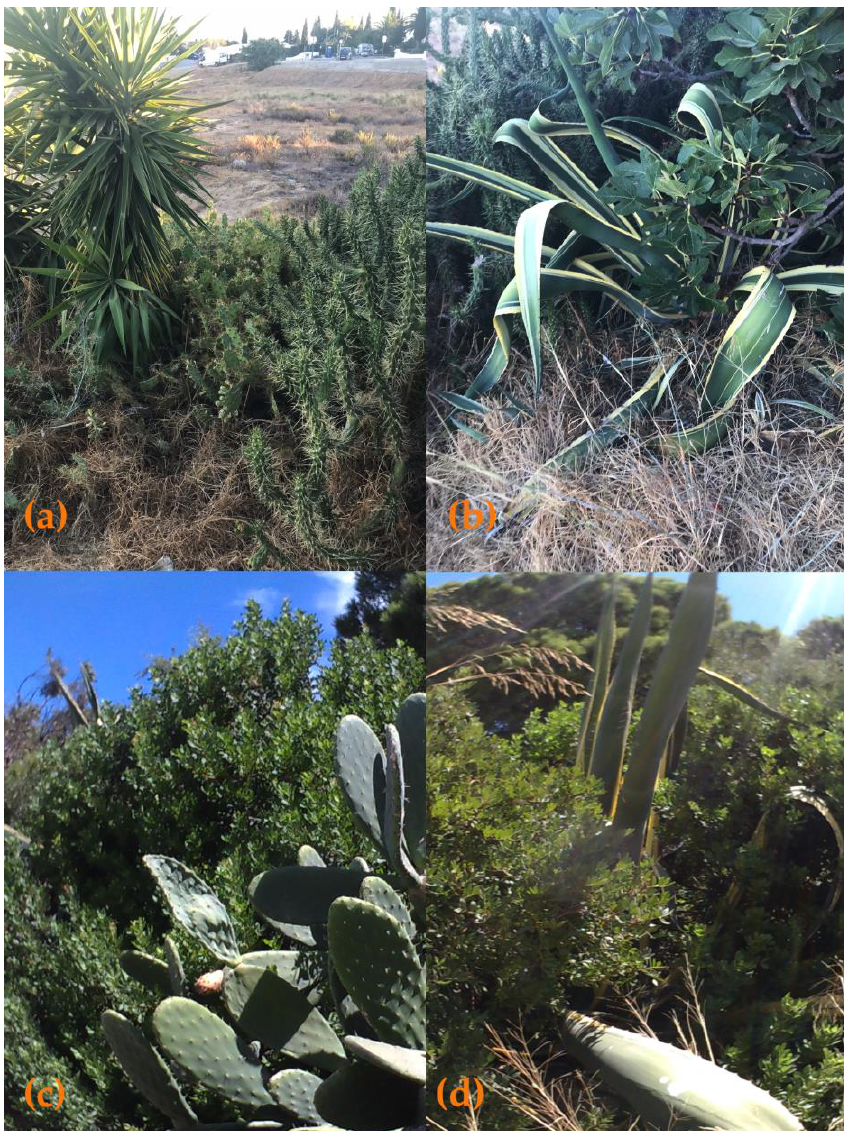
Figure 8. ( a ) A specimen of Yucca spp. growing together with Cylindropuntia spp. (Engelm.) F. M. Knuth and Opuntia dillenii (Ker Gawl.) Haw.; ( b ) set of Cylindropuntia spp. (Engelm.) F. M. Knuth, Agave americana L. and Ficus carica L.; ( c ) specimen of Opuntia ficus-indica (L.) Miller growing in the middle of Rhamnus alaternus L. and ( d ) Agave americana L. growing among specimens of Rhamnus alaternus